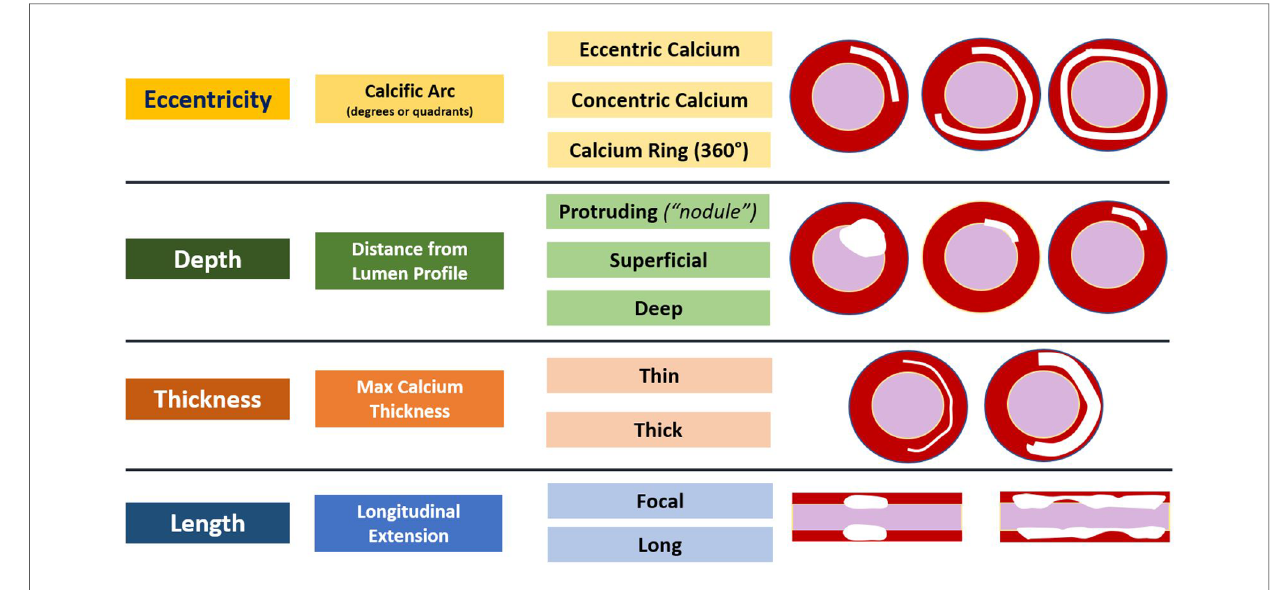
FIGURE 1 Summary of the variables that predict stent under-expansion and malposition as well as diagrammatic representations.